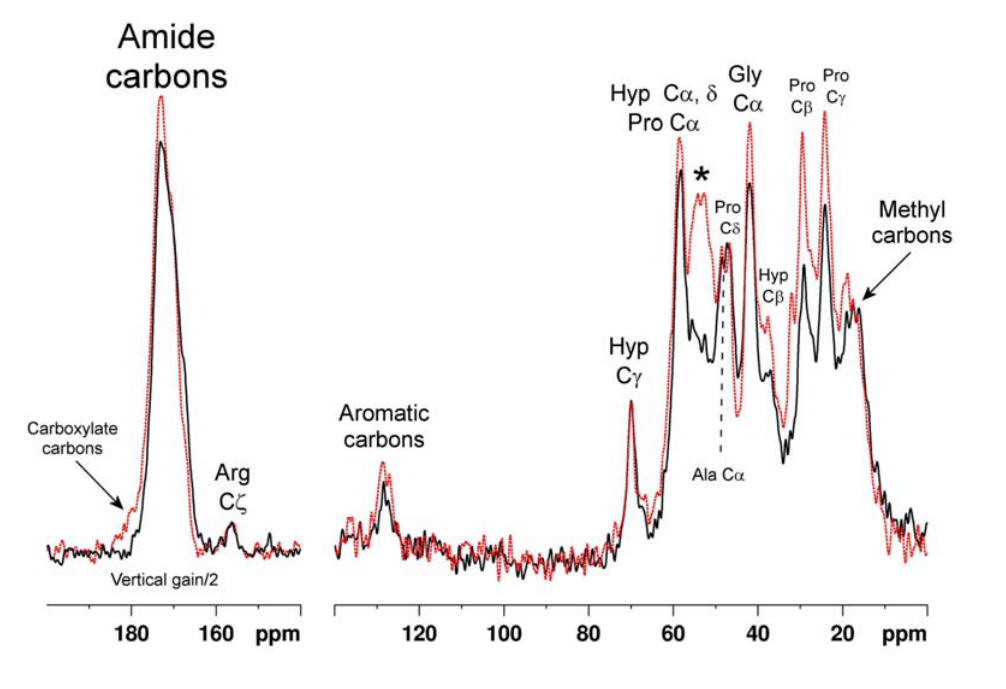
Figure 3. Solid state 13 C CP-MAS spectrum of leather tanned with chromium (III) (the black solid trace) superimposed on a spectrum of untanned hide (red dotted trace) . Some assignments to carbon atoms in specific collagen amino acid residues or residue types are also indicated. The asterisk marks the envelope of overlapped signals from inter alia the α - carbons of several types of residues, including aspartate and glutamate. Ala – alanine, Gly – glycine, Hyp – hydroxyproline, Pro –